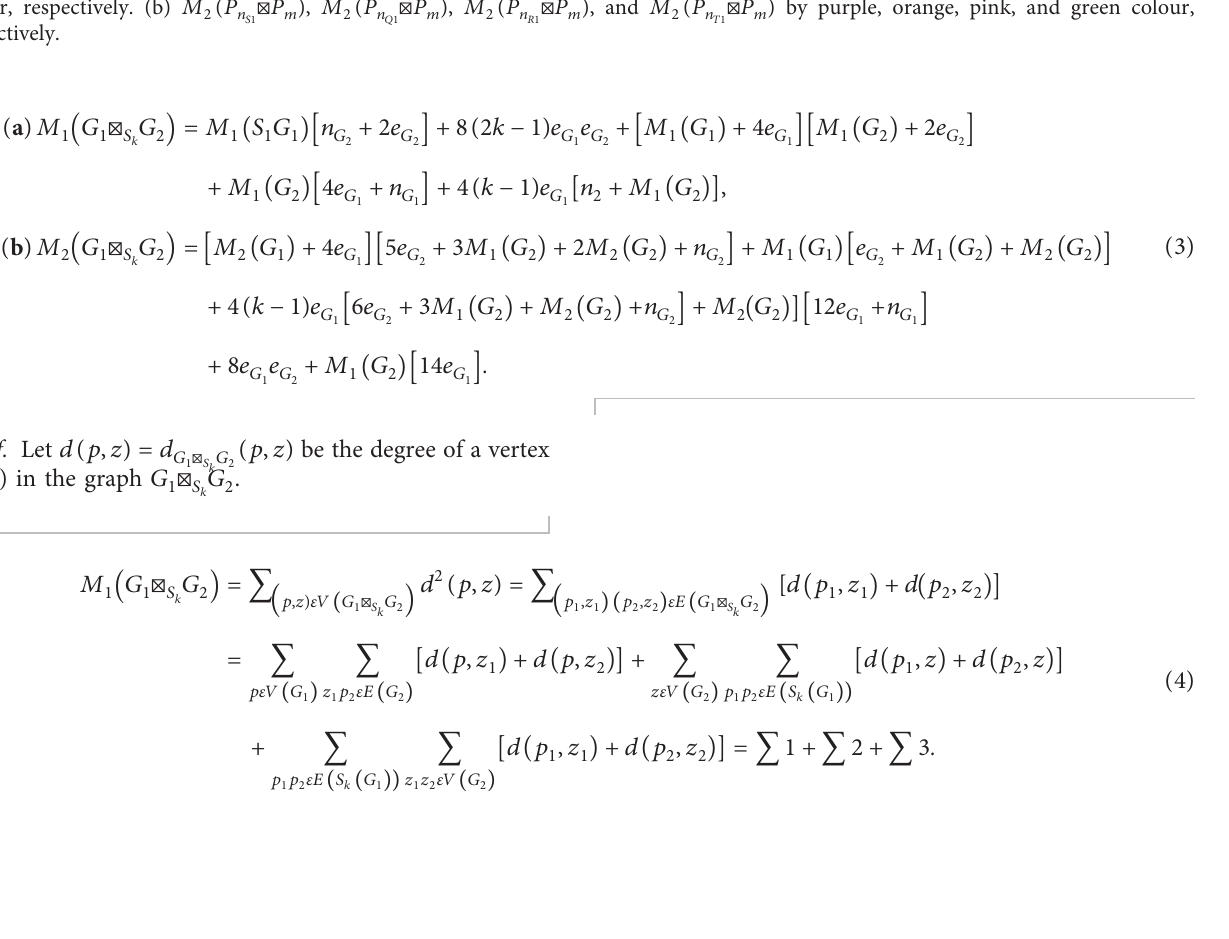
( P P ) by red, green, orange, and purple n T 1 ⊠ m 1